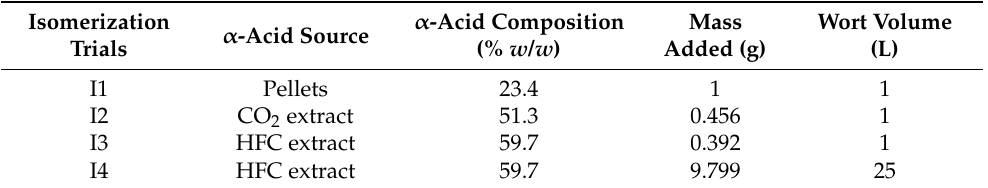
Table 2. α -acid sources used for the isomerization trials carried out at laboratory and pilot scale, their composition, and volume of liquid